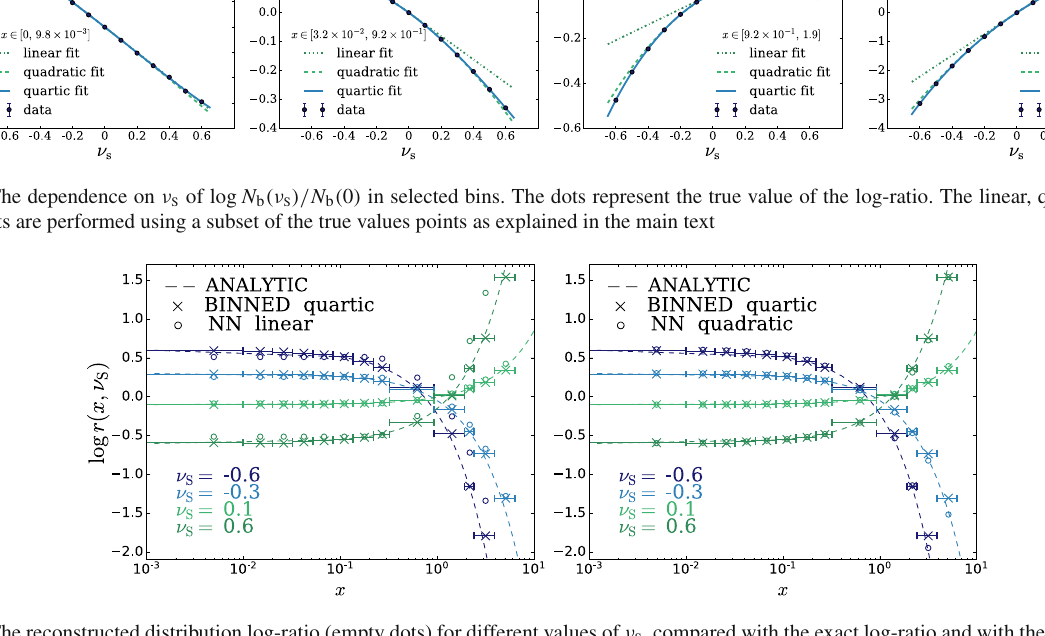
Fig. 3 The reconstructed distribution log-ratio (empty dots) for different values of ν s , compared with the exact log-ratio and with the fourth-order binned approximation described in the main text. The two panels correspond to truncations of the series in Eq. (31) at linear and at the quadratic order